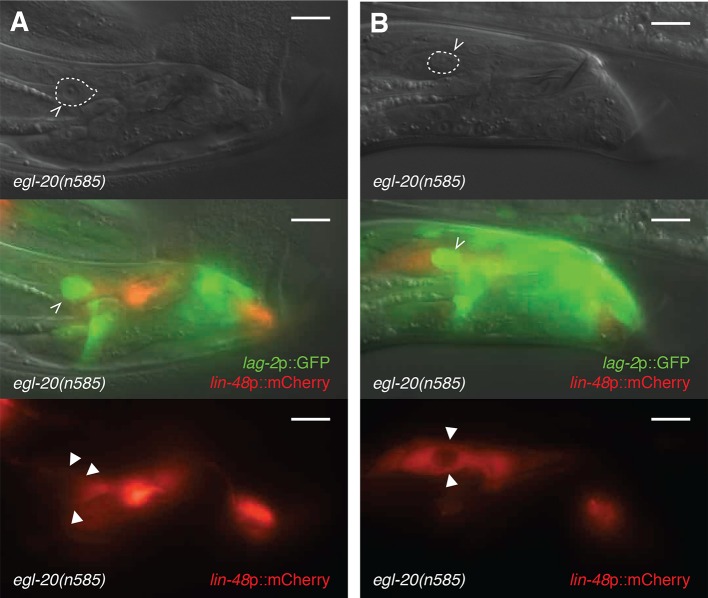
Surviving linker cells in egl-20 mutants are not
engulfed, but dying ones are.(A,B) 2h-old egl-20(n585) adult male with a
surviving linker cell. lag-2p::GFP marks the linker cell
(white carets). lin-48::mCherry marks the U.l/rp cells
(arrowheads). Note that in (A), the U.l/rp cells abut the
surviving linker cell without surrounding it completely, whereas in
(B), the U.l/rp cells have entirely engulfed the linker
cell. Scale bars, 10 μm.